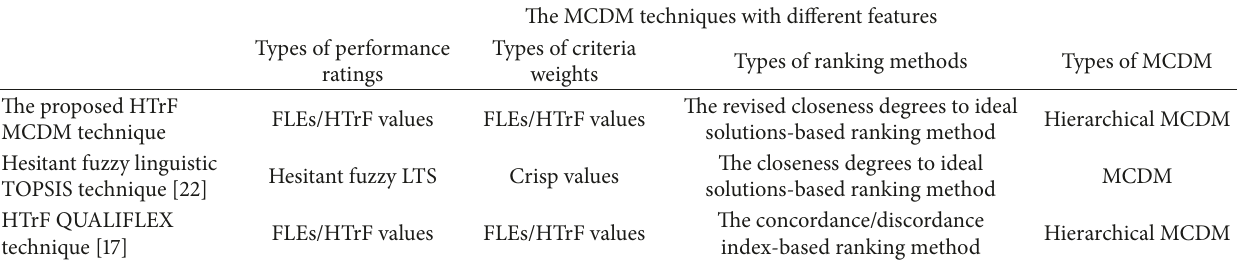
Table 7: Distinct characteristics of three different MCDM